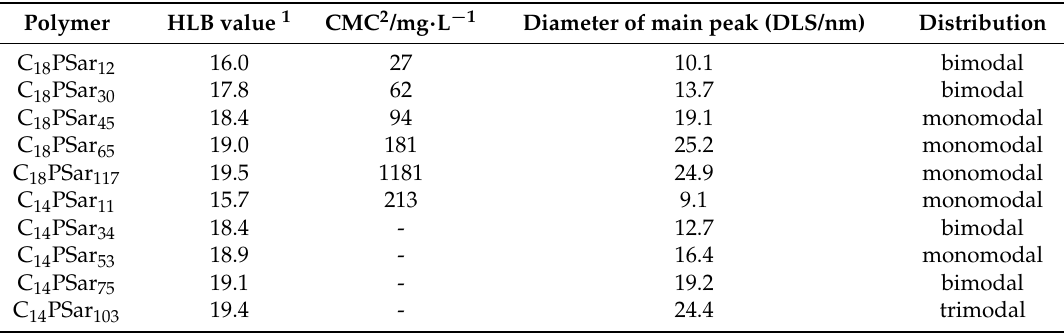
Table 2. Calculated HLB values and measured